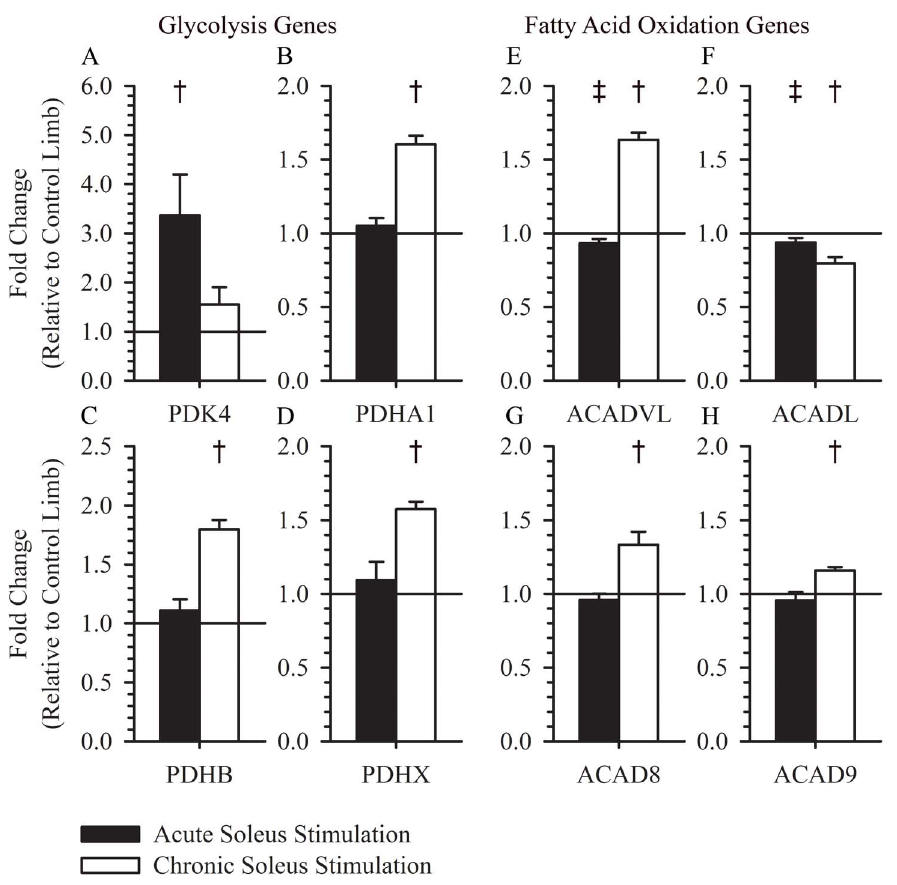
Fig. 4. Expression of glycolysis and fatty acid oxidation genes following acute or chronic stimulation. PDK4 was increased 3 hours after a single session of muscle stimulation (3.37 ¡ 0.83, p 5 0.008), but was unchanged after . 1 year of soleus training (1.55 ¡ 0.35, p 5 0.21) (A). PDHA1 (1.60 ¡ 0.057, p , 0.001) PDHB (1.80 ¡ 0.08, p , 0.001), and PDHX (1.57 ¡ 0.05, p , 0.001) were increased after . 1 year of muscle training, but were unchanged 3 hours after a single session of muscle stimulation (1.05 ¡ 0.05, p 5 0.46, 1.11 ¡ 0.09, p 5 0.35, 1.09 ¡ 0.13, p 5 0.59; respectively) (B, C, and D). ACADVL (0.93 ¡ 0.03, p 5 0.064) was decreased 3 hours after a single session of muscle stimulation, but was increased after . 1 year of muscle training (1.63 ¡ 0.049, p 5 0.049) (E). ACADL (0.94 ¡ 0.031, p 5 0.098) was decreased 3 hours after a single session of muscle stimulation and after . 1 year of muscle training (0.80 ¡ 0.044, p 5 0.025) (F). ACAD8 (1.33 ¡ 0.089, p 5 0.023) and ACAD9 (1.16 ¡ 0.023, p 5 0.006) were increased after . 1 year of muscle training, but were unchanged 3 hours after a single dose of muscle stimulation (0.96 ¡ 0.042, p 5 0.33, 0.96 ¡ 0.06, p 5 0.39; respectively) (G and H). { indicates a p-value , 0.05 for a within group paired t-test. { indicates a p-value , 0.10 for a within group paired t-test.